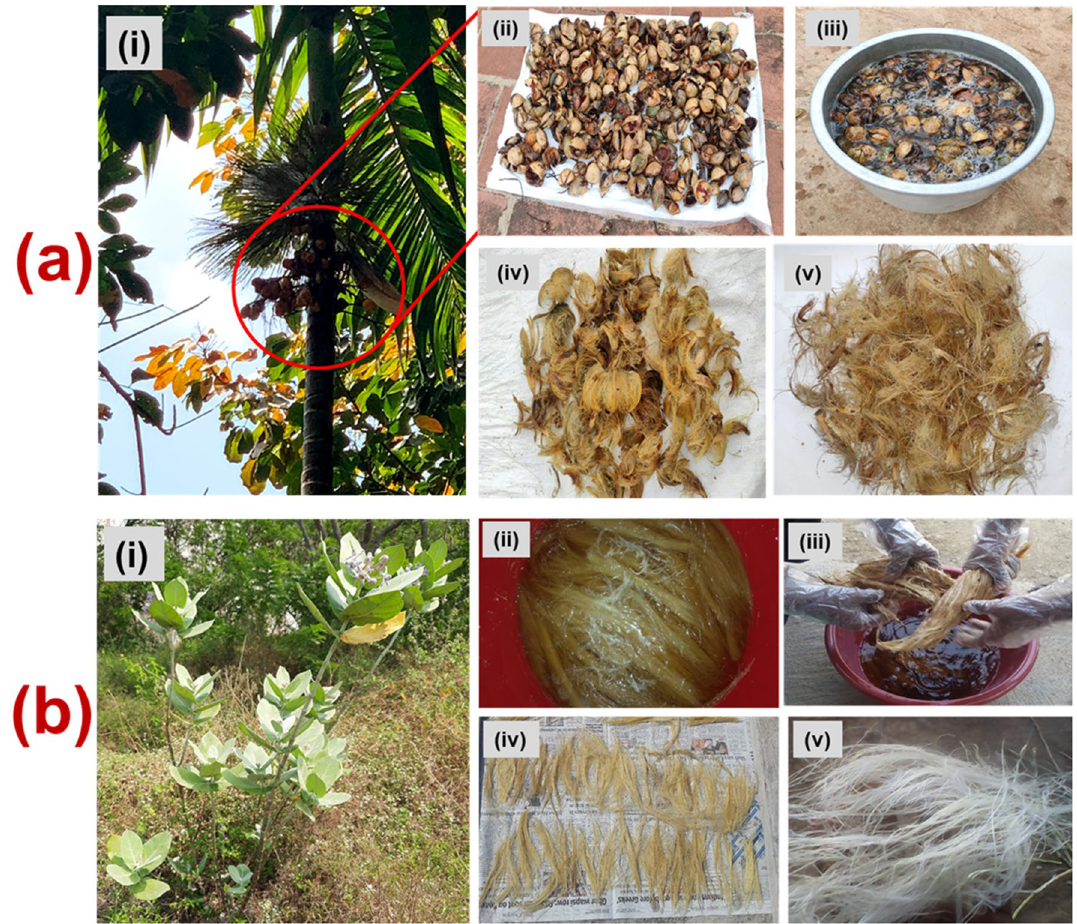
Figure 1. Fibre extraction process (a) Extraction of Areca fine fibre, (i) Areca nut palm plant, (ii) Areca nuts, (iii) retting process, (vi) drying of extracted fibre (viii) fibre after drying. (b) Extraction of Calotropis gigantea fibre, (i) Calotropis gigantea plant, (ii) retting of stem stalks of Calotropis gigantea plant, reproduced with permission form Ref. [3], (iii) cleaning of extracted fibre, reproduced with permission form Ref. [3], (iv) drying of extracted fibre, (v) extracted fibre, reproduced with permission form Ref.